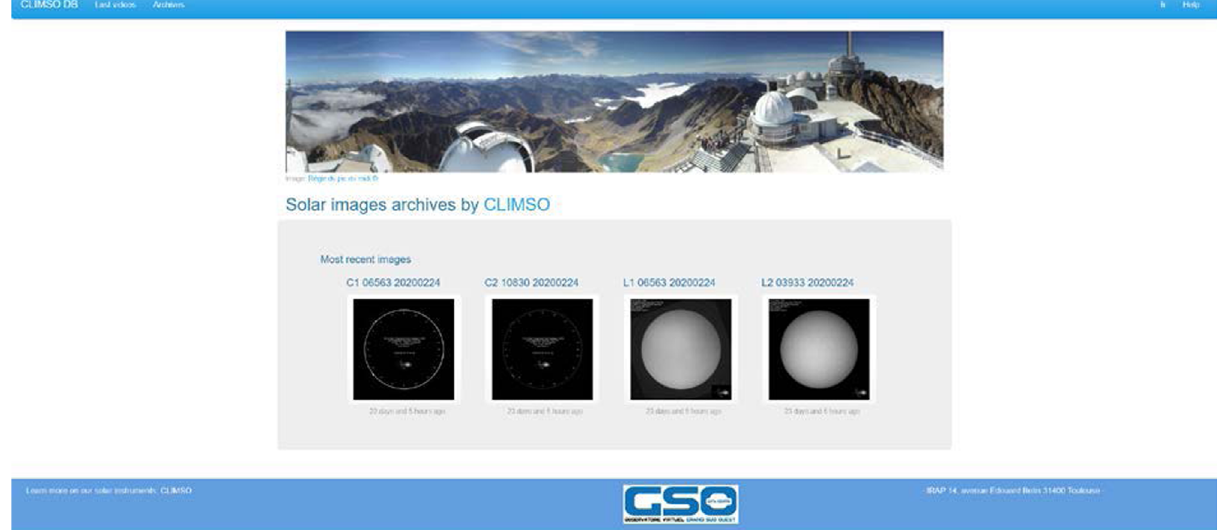
Fig. 10. Portal of the Climso-DataBase web site